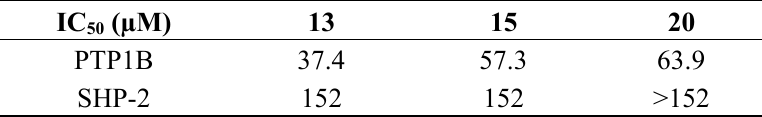
Table 2. Selective inhibitory activity against PTP1B and